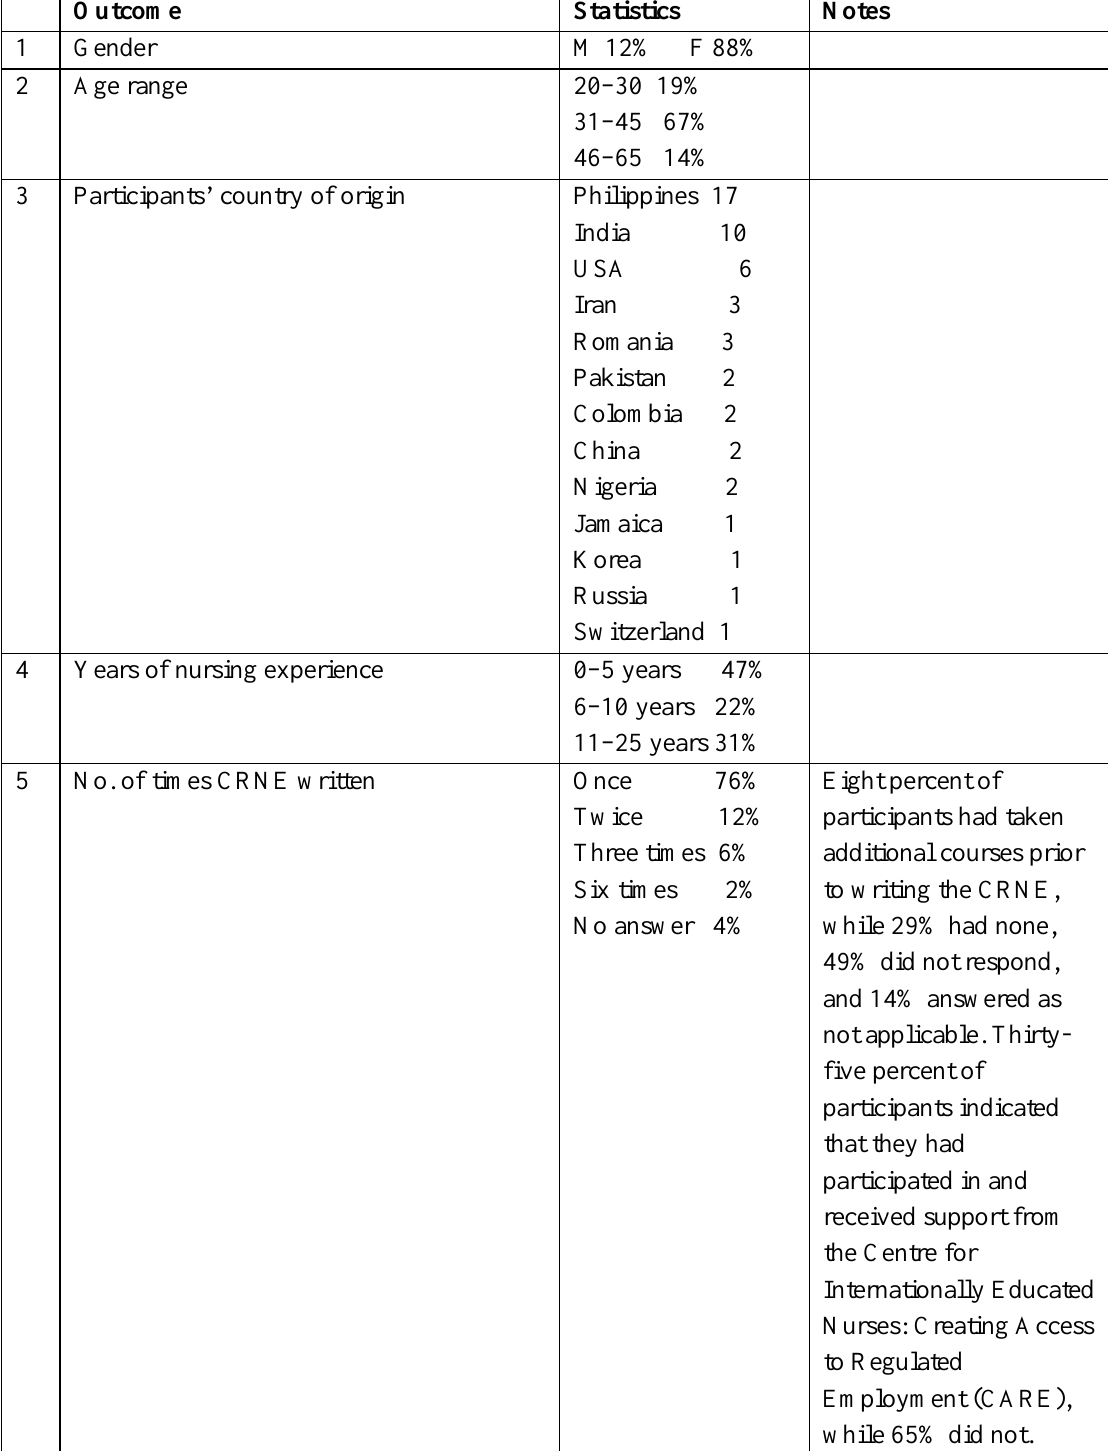
Table 2 Demographic Findings